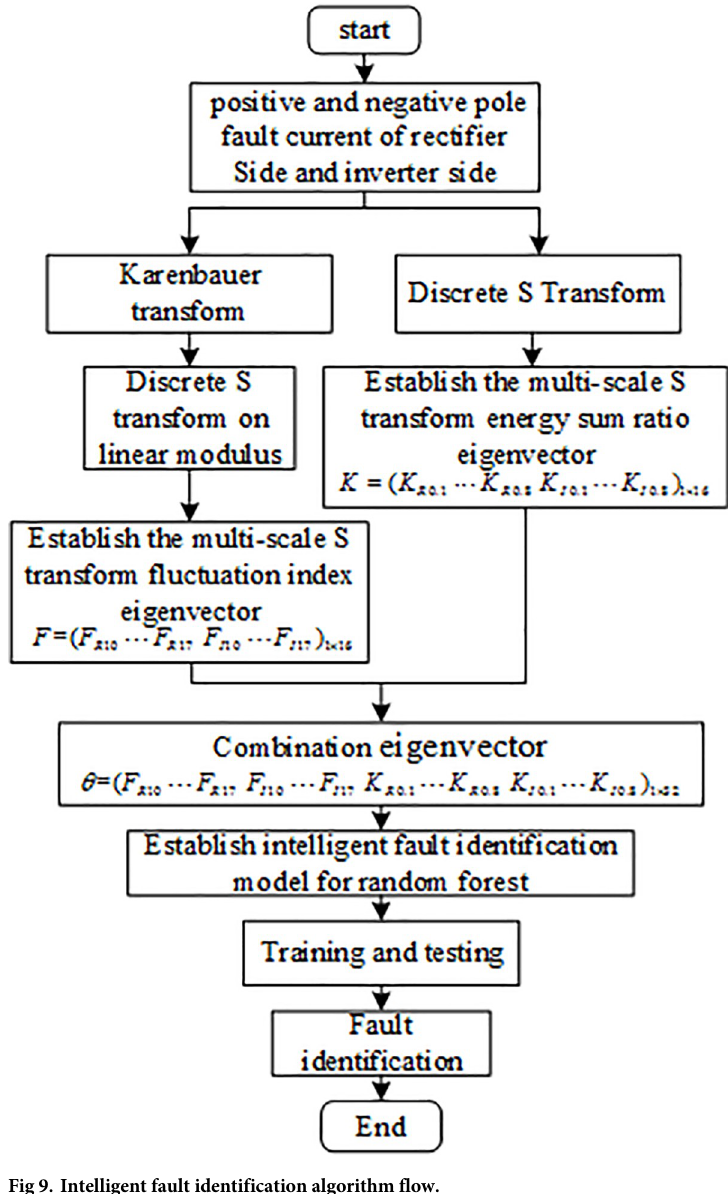
Fig 9. Intelligent fault identification algorithm flow.